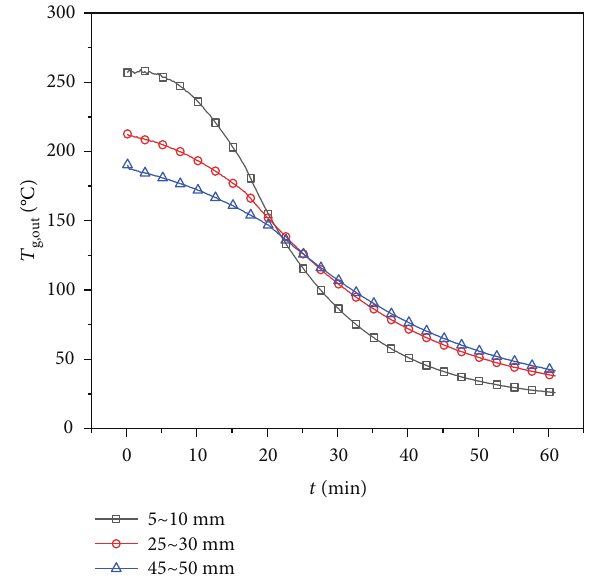
Figure 10: Gas outlet temperatures T